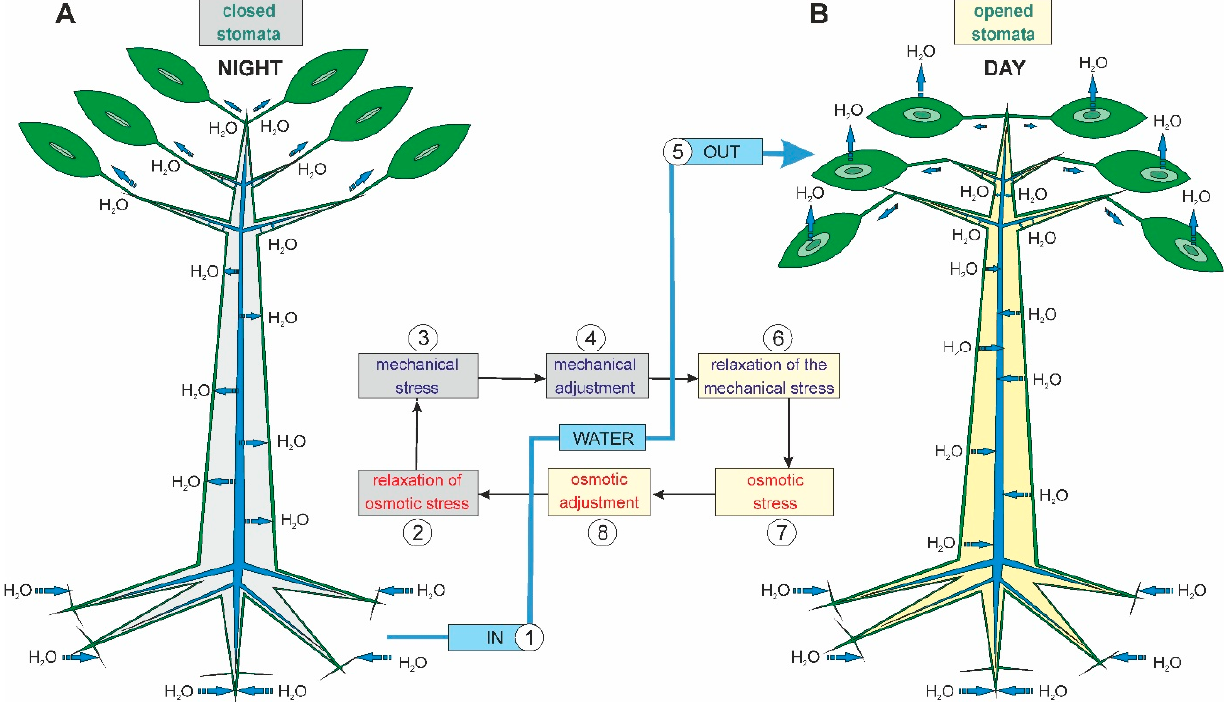
Figure 4. Proposed scheme showing the radial direction of water flow at night, when the stomata are closed ( A ), and during the day, when the stomata are opened ( B ). During the day ( B ), the sources of water used in transpiration are both the apoplast and symplast (mainly phloem) and the external environment (mainly soil). Transpiration (5), due to the lateral transport of water from the phloem to the xylem, leads to a relaxation of mechanical stress (6) and an increase in osmotic stress (7), which triggers a process of adaptation to osmotic stress (8). At night ( A ), after the stomata close, water taken up from the environment (1) is redirected to living cells, which have low water potential as a result of the daytime adaptation to water stress. Increase in tissue hydration results in the relaxation of osmotic stress (2) and the generation of mechanical stress (3). Elastic and plastic deformation of the cell walls of the phloem, the vascular cambium, and the xylem is an adaptive response to mechanical stress (4) generated during the night.